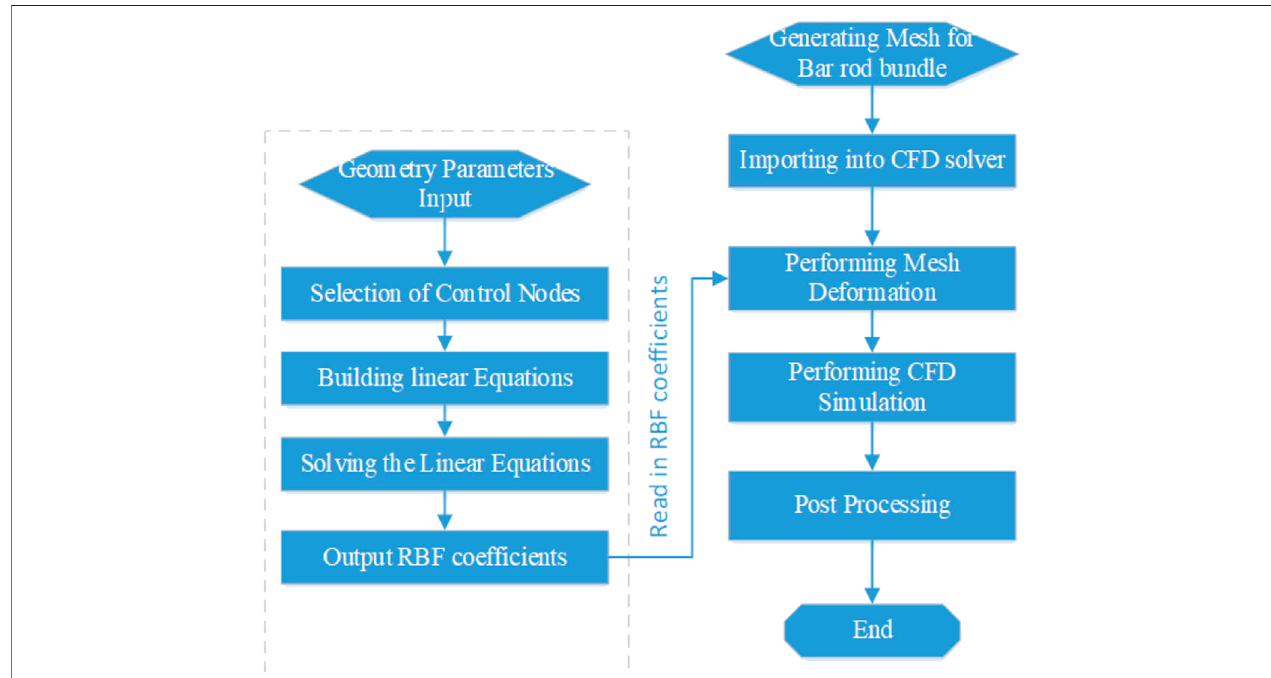
FIGURE 2 | The proposed mesh